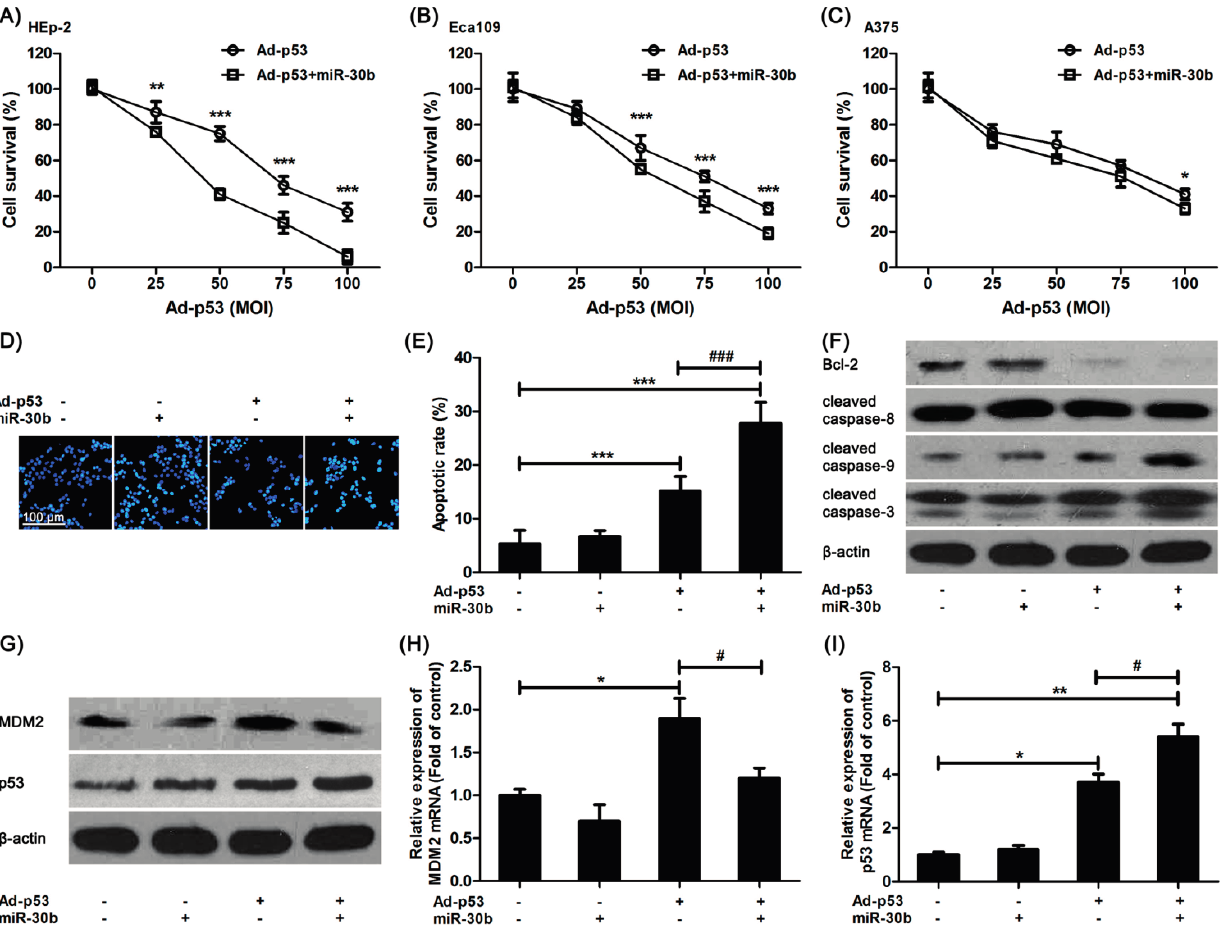
Figure 2. Overexpression of miR-30b improved Ad- p53 -induced cell apoptosis via enhancing p53 pathway. ( A ) After HEp-2 cells were infected by miR-30-lentivirus vector for 16 h, Ad- p53 vector at different MOIs was added into culture medium for another 24 h, then MTT assay was performed to detect cell viability; ( B ) Similar MTT assay was performed in Eca109 cells; ( C ) Similar MTT assay was performed in A375 cells. * p < 0.05, ** p < 0.01, *** p < 0.001 compared to Ad- p53 -treated alone cells, n = 6; ( D ) After HEp-2 cells were infected by miR-30-lentivirus vector (200 MOI) for 16 h and stimulated with Ad- p53 (50 MOI), the cells were stained with Hoechst33342 and bright nuclei indicated apoptotic cells. Scale bar = 100 μ m and referred to all panels; ( E ) Statistical analysis of Hoechst staining, *** p < 0.001 compared to untreated HEp-2 cells, ### p < 0.001 compared to Ad- p53 -treated alone group, n = 4; ( F , G ) HEp-2 cells were treated as in Hoechst staining, western blot was performed. β -actin was used for loading control. All blots were repeated for at least three times; ( H , I ) HEp-2 cells were treated as in Hoechst staining, qRT-PCR was performed to detect the mRNA expression of p53 and MDM-2. * p < 0.05, ** p < 0.01 compared to untreated HEp-2 cells, # p < 0.05 compared to Ad- p53 -treated alone group, n =